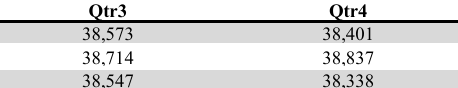
Public debt as percent of GDP